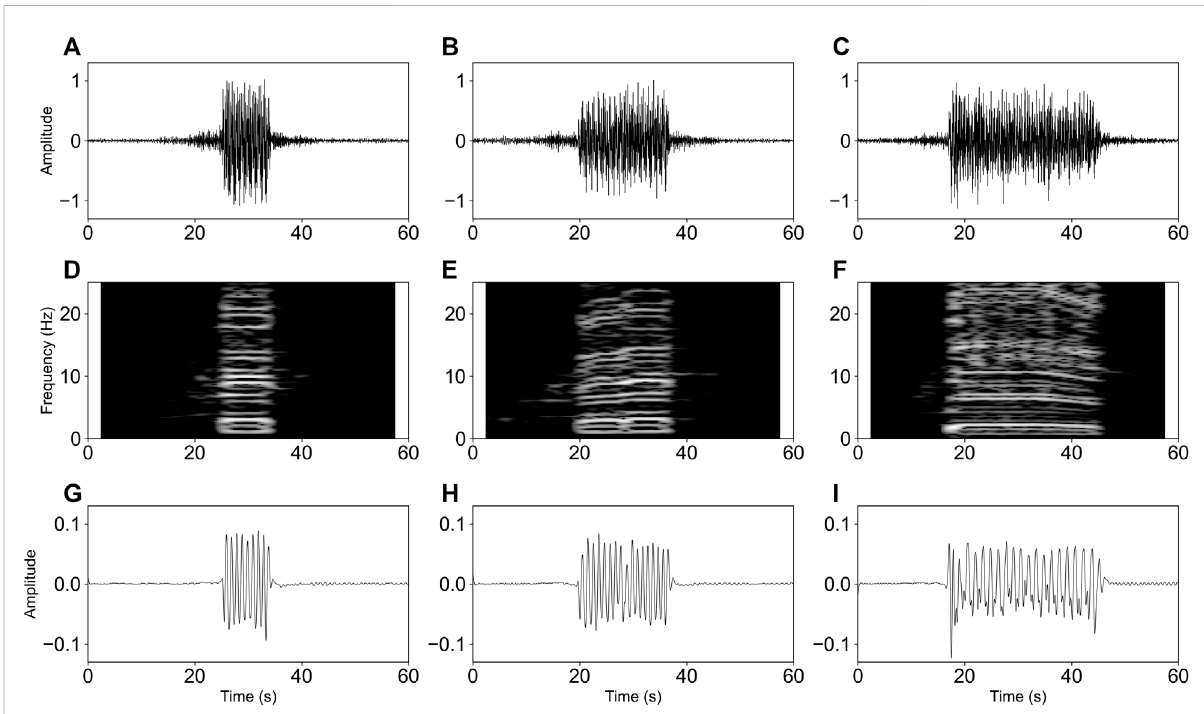
FIGURE 3 Typical train-induced signals of CH500 (A – C) , their spectrograms (D – F) , and lowpass fi ltered signals (G – I) . The blue circles denote